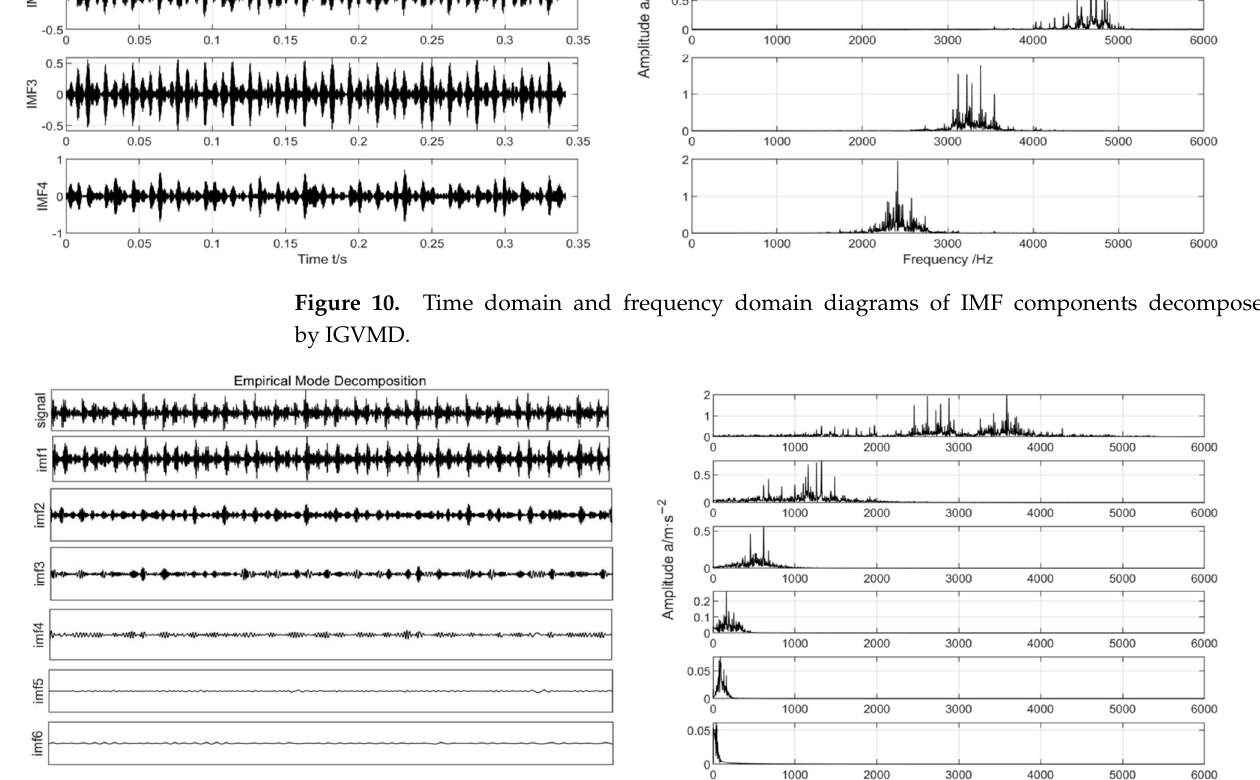
Figure 11. Time domain and frequency domain diagrams of IMF components decomposed by EMD.